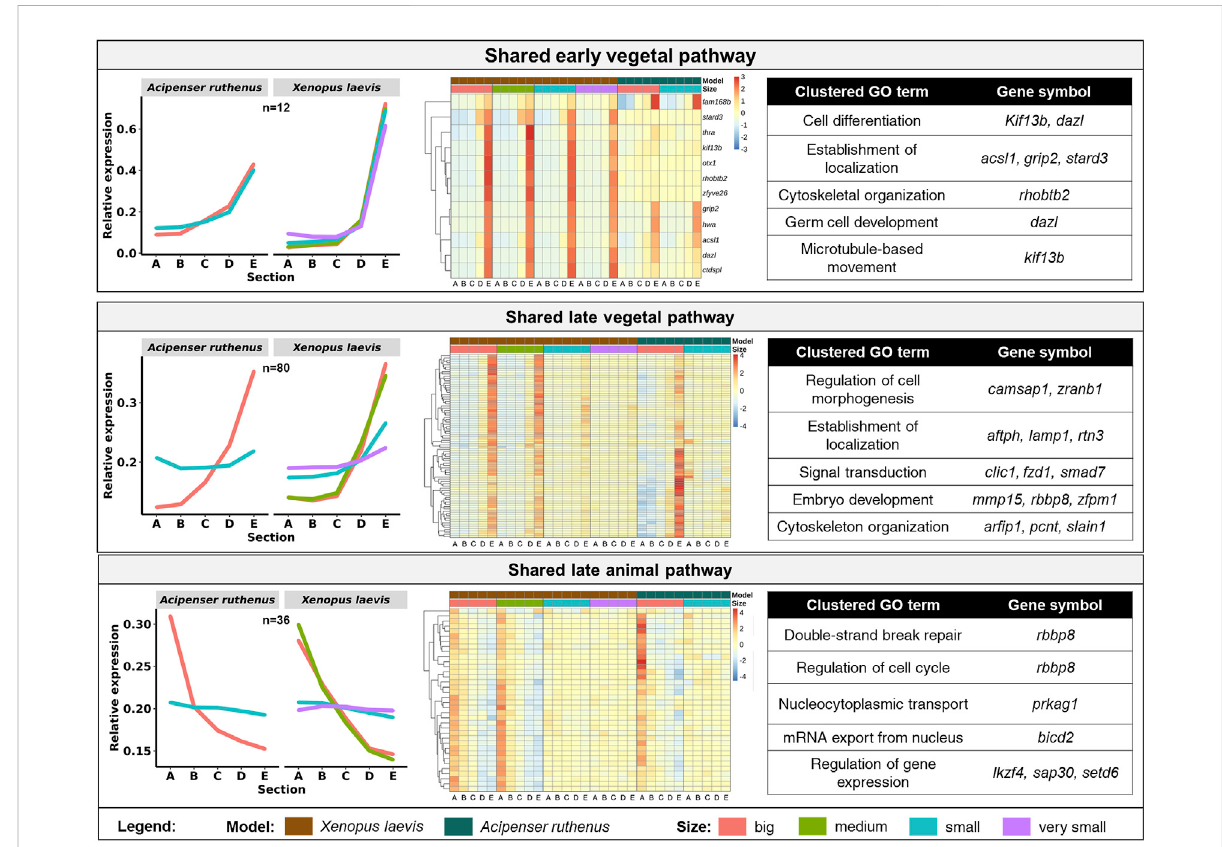
FIGURE 7 Vegetal and animal transcripts with similar temporal sub-cellular pro fi les in Xenopus laevis and Acipenser ruthenus . Heatmap is based on the Z-score of the transcript expression relative to the oocyte stage of the model. The Gene Ontology terms are those found associated with the given group oftranscripts. Transcripts were fi lteredto include onlythose with either limited (early vegetal < ~1.5x) or enhanced (late pathways > ~1.2x) fold differences between stage sections of interest. The sections correspond to the regions of the oocyte that were cryosectioned, whereby sections A - extremely animal, B - animal, C - central, D - vegetal, E - extremely